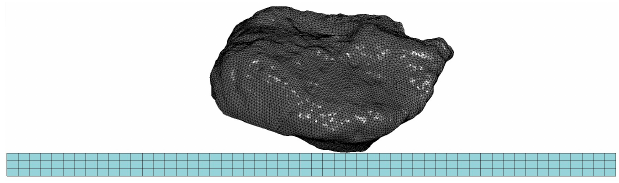
Figure 3. The finite element model of coal drop test.